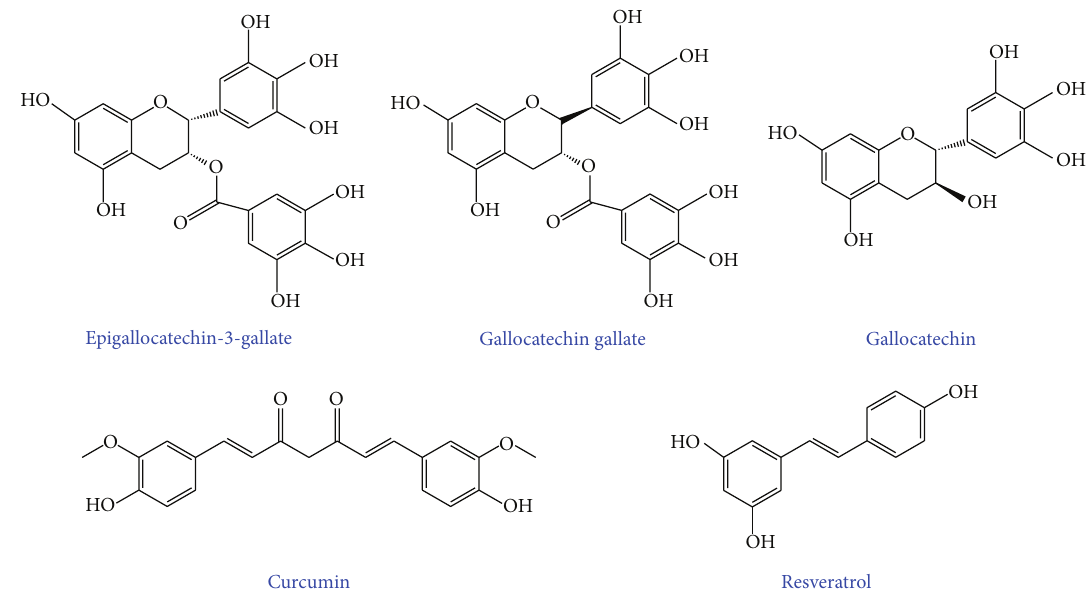
Figure 4: Chemical structures of the most studied polyphenolic small molecule inhibitors of hIAPP aggregation: epigallocatechin gallate (EGCG), gallocatechin gallate (GCG), gallocatechin (GC), curcumin, and